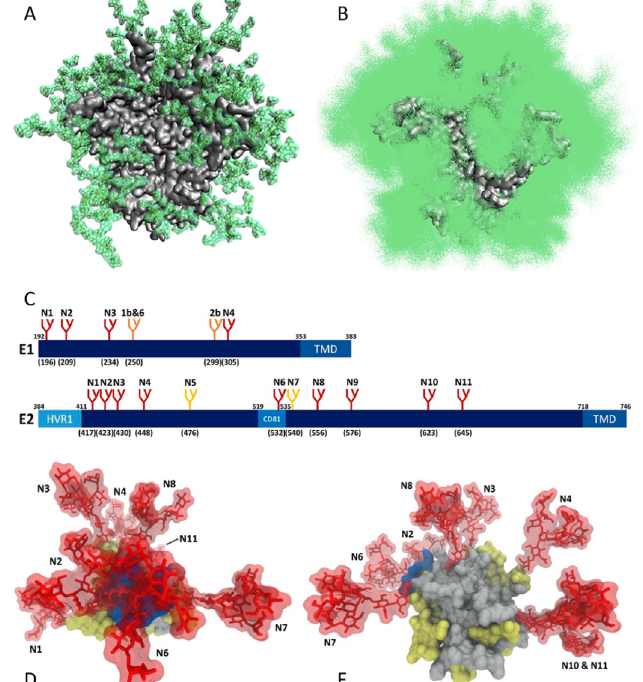
Figure 1. Dynamic glycan shield of viral surface glycoproteins. (A) Single snapshot of the modeled natively glycosylated structure of the soluble HIV-1 Env trimer, BG505 SOSIP.664 gp140, with each glycan taking up a particular conformation; (B)